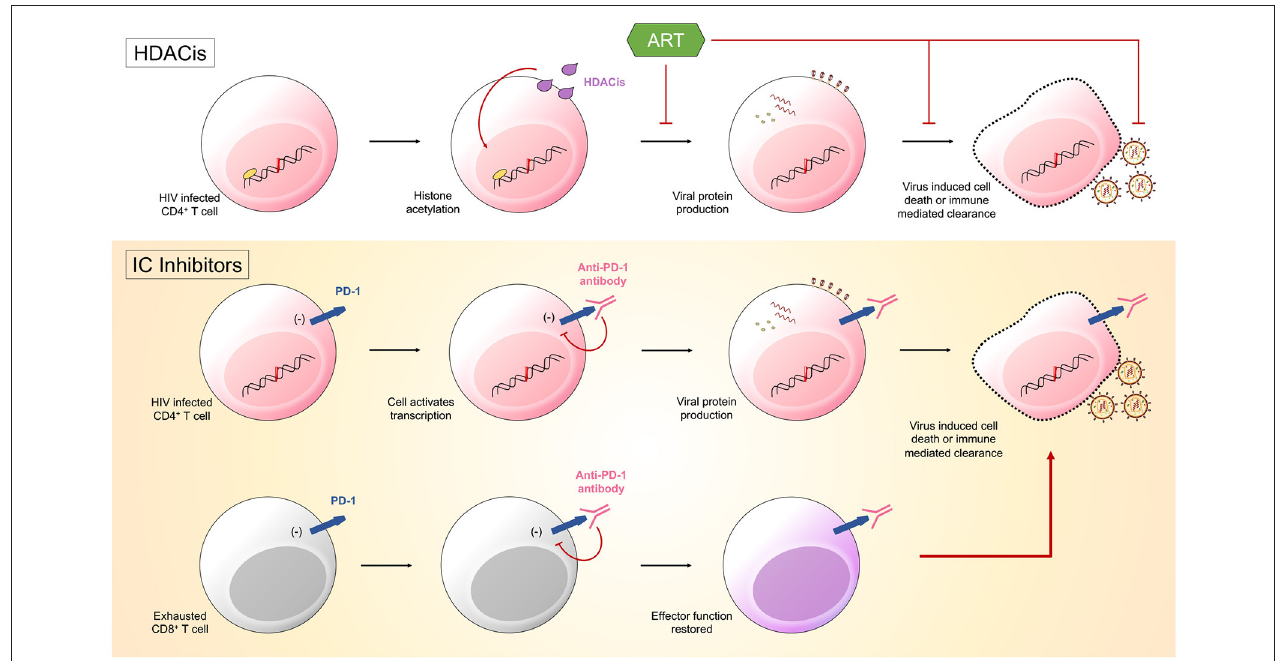
FIGURE 1 | Latency reversing agents (LRA) are one half of the “shock and kill” approach. They function to induce HIV transcription. Histone deacetylase inhibitors (HDACis) promote histone acetylation and induce transcription of viral products. Immune checkpoint (IC) inhibitors could also function as LRA. Anti-PD-1 antibodies bind PD-1 on both HIV infected CD4 + T cells and HIV-specific CD8 + T cells. The binding of PD-1 by the antibody will disinhibit signals sent into the cells by the immune checkpoint molecule. Cells will become transcriptionally active, with CD4 + T cells producing viral products that ultimately result in the death of the cell, and CD8 + T cells having effector function restored, allowing them to target infected CD4 + T